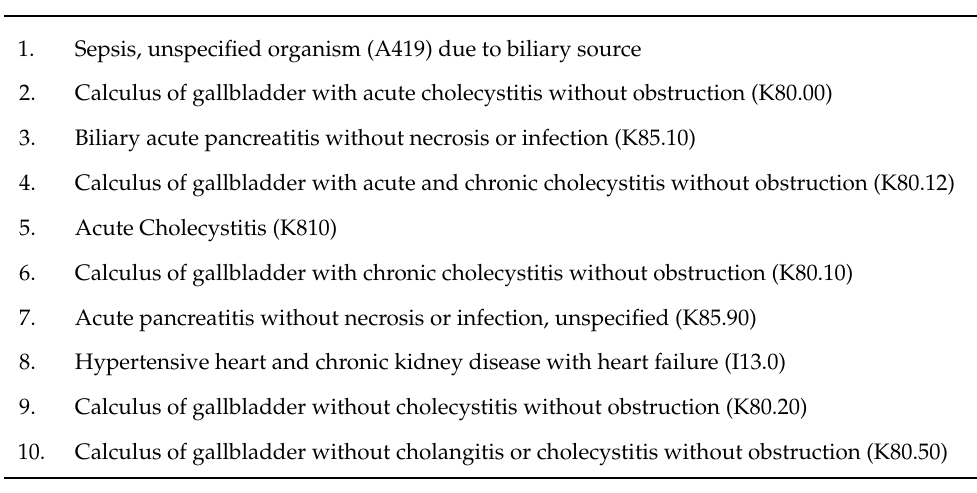
Table 2. Comparison between index admission and readmission.